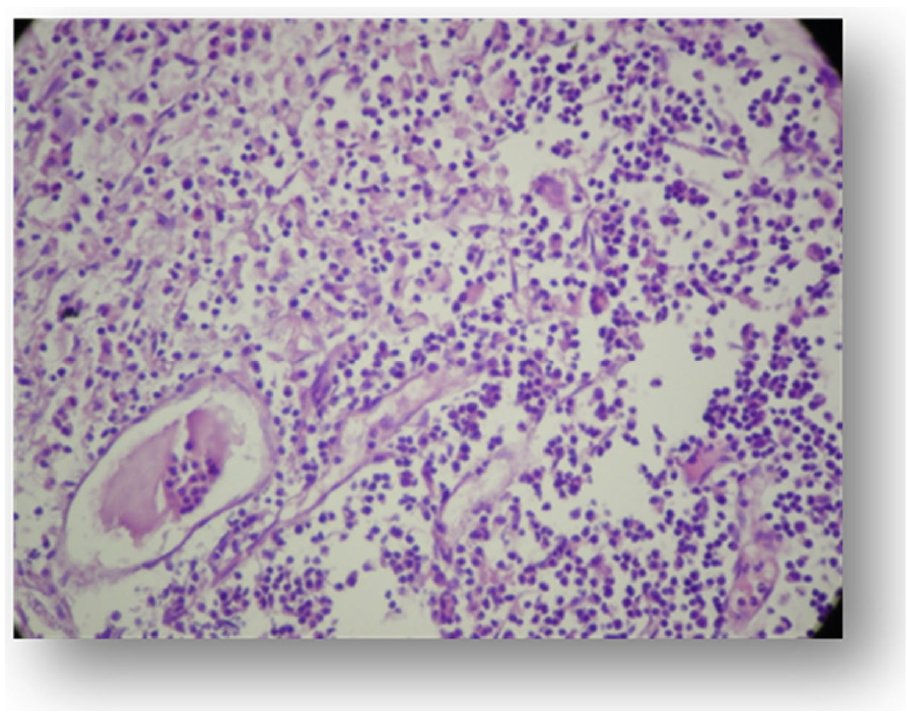
Figure 2. Dental pulp aspect (coronal) of a 36 year old male, type 2 diabetes, HE staining, × 200.